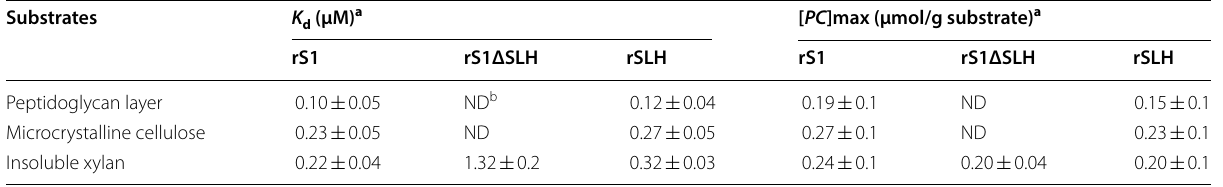
Table 2 Binding affinities and capacities of rS1 and its truncated derivatives toward the peptidoglycan cell surface layer and insoluble